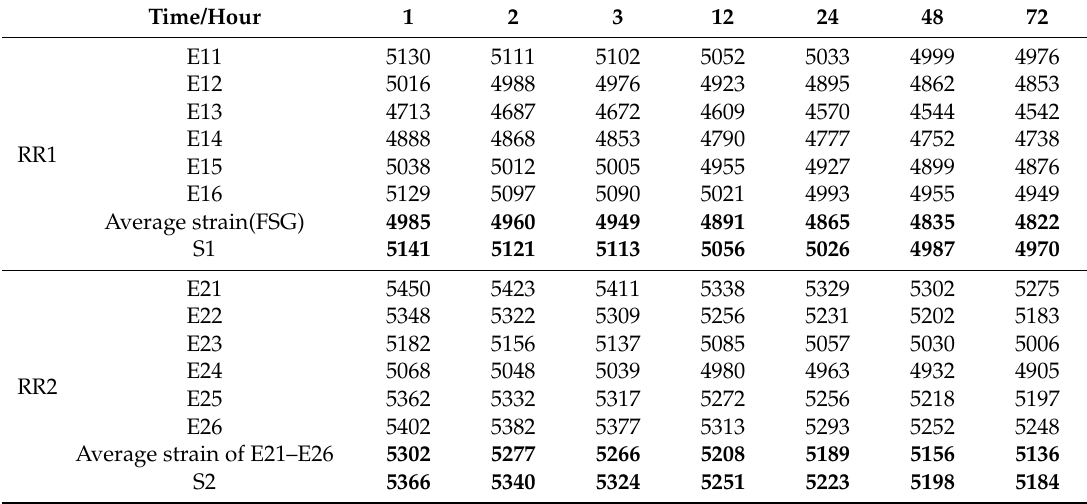
Table 9. The results of strain measurement from various sensors at Step II. (Unit: µε